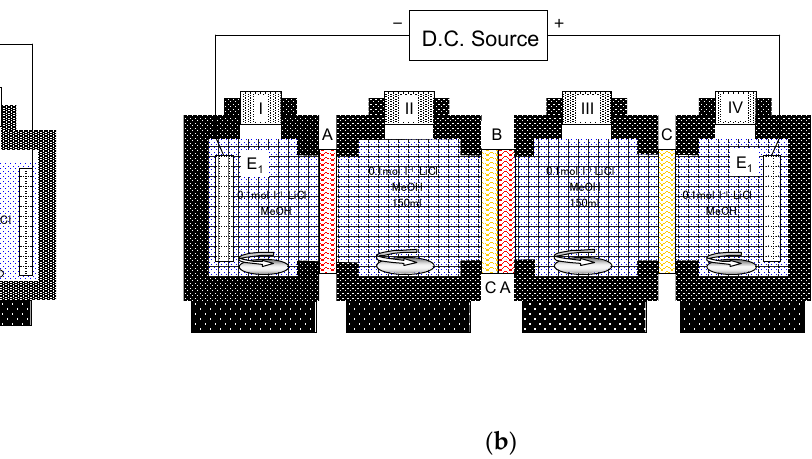
Figure 1. ( a ) Schematic diagram of typical apparatus for the current–voltage measurements. B is the BPM (C and A are CEL and AEL, respectively), E 1 is Pt electrode, and E 2 is Ag/AgCl electrode. The current–voltage characteristics in the other organic solvent systems were measured in the same manner. ( b ) Schematic diagram of typical apparatus for measuring the pH shift. B is the BPM (C and A are CEL and AEL, respectively), C is CEM, A is AEM, and E 1 is Pt electrode. The current–voltage characteristics in the other organic solvent systems were measured in the same manner.